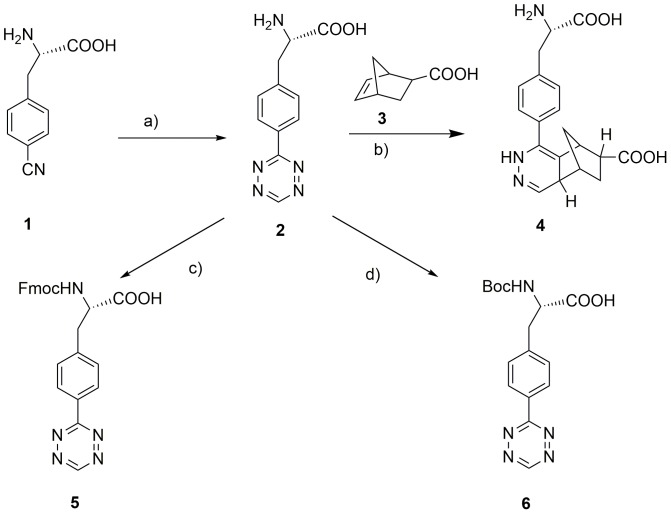
Synthetic route of tetrazine-containing amino acid (S)-3-(4-(1, 2, 4, 5-tetrazin-3-yl) phenyl)-2-aminopropanoic acid 2 and protected tetrazine-containing amino acid 5 and 6, and the IED-DA reaction of 2 with 5-norbornene-2-carboxylic acid 3 give 4.a) (i) Formamidine acetate (4 eq), N2H4 (40 eq), S (1 eq), r.t, 22 h; (ii) CH3COOH, NaNO2 (5 eq), 0°C, 30 min, 64.9%. b) Phosphate buffered solution (PBS), r.t, 30 min. c) Fmoc-OSu (1.5 eq), 1: 1 Dioxane/H2O (V/V), NaHCO3 (2.5 eq), 0°C, overnight, 64.5%. d) Boc2O (2 eq), 1: 1 Dioxane/H2O (V/V), NaHCO3 (2.5 eq), 0°C, 8h, 72.3%.